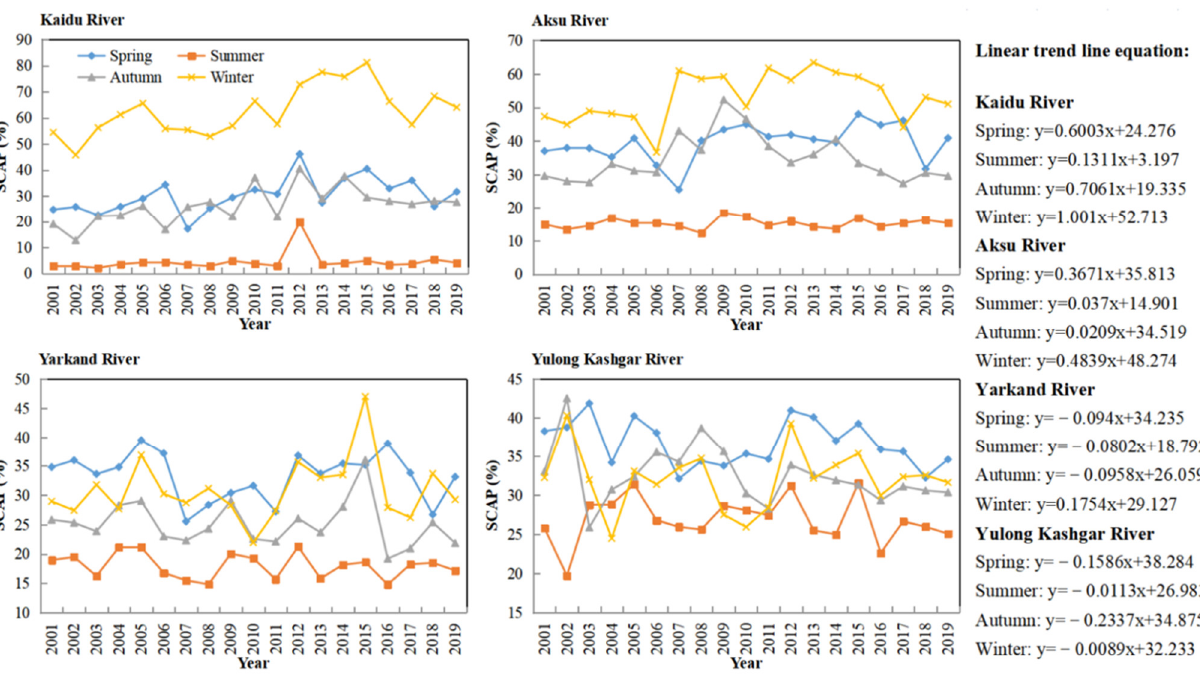
Figure 6. Seasonal variations of SCAP in the Tarim River Basin from 2001 to